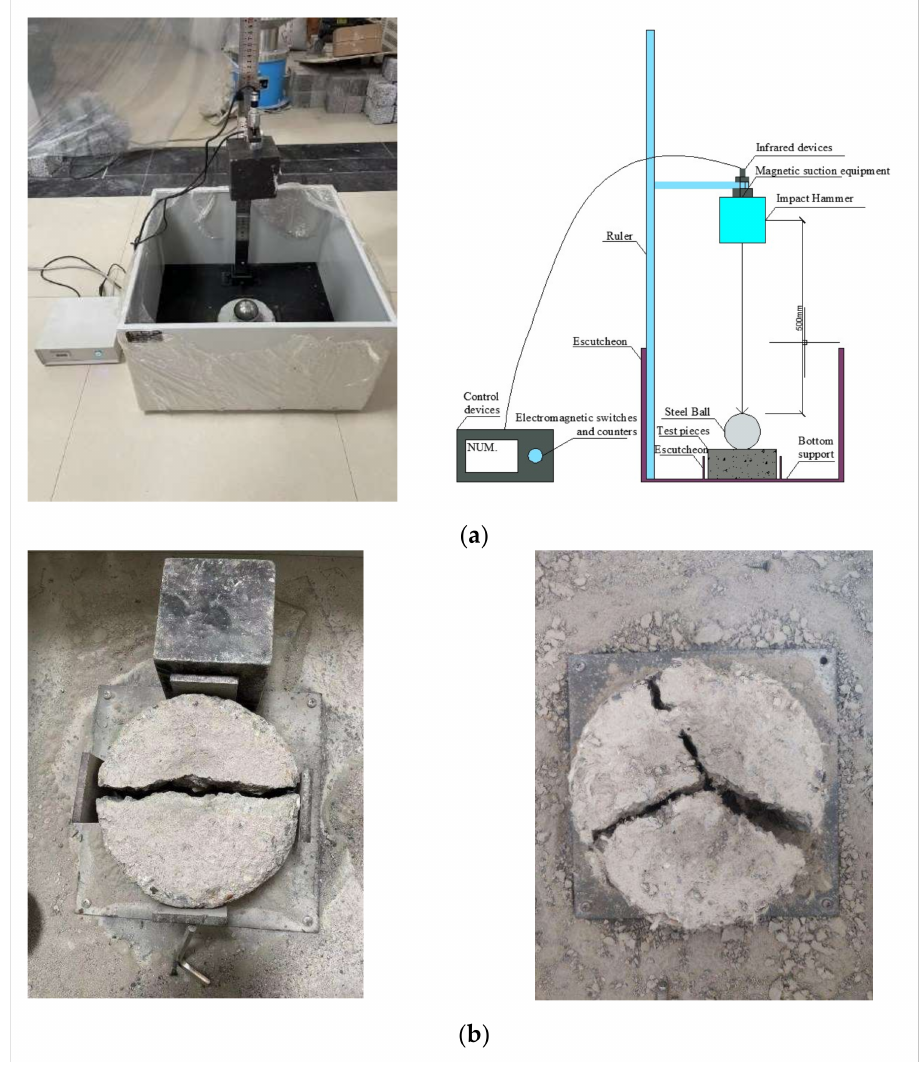
Figure 3. ( a ) Schematic diagram of the UHTCC impact test. ( b ) Impact test damage